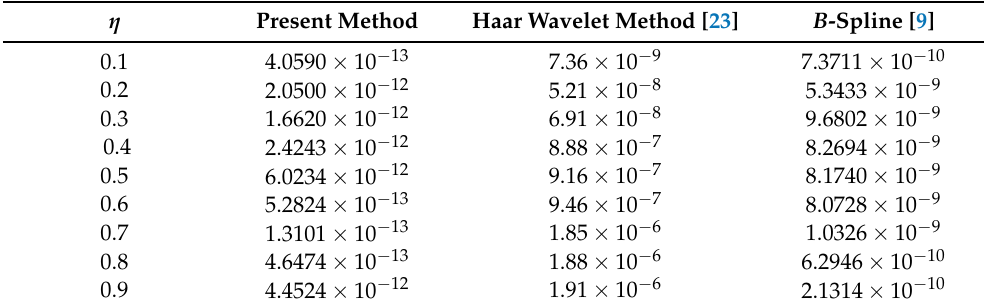
Table 2. Comparison of the proposed method’s absolute error with the HWM and B -spline methods of Example 1 for ζ =